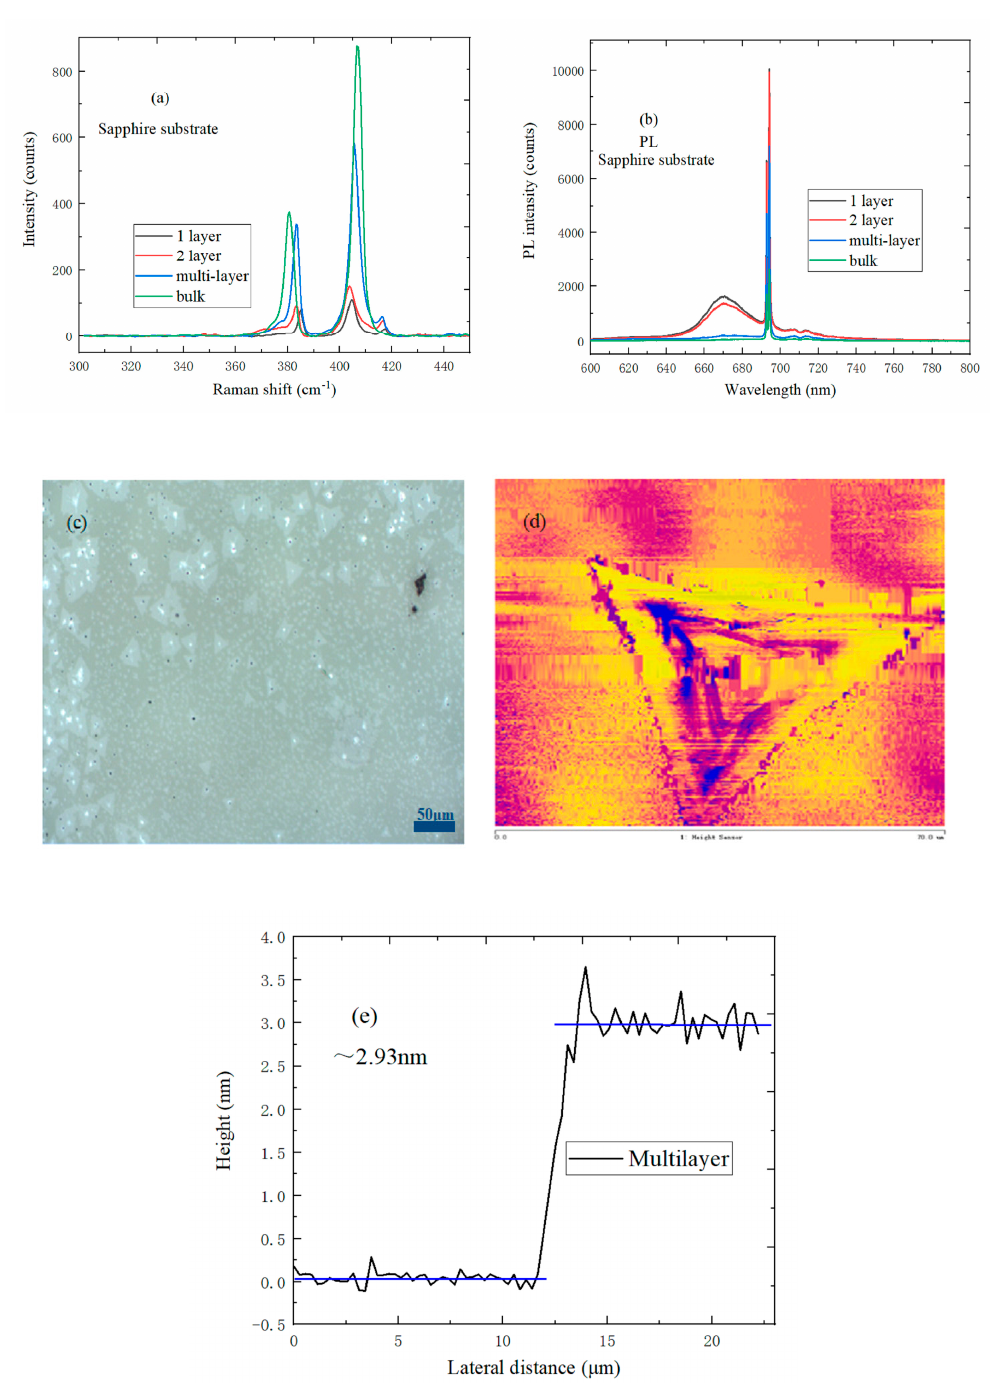
Figure 6. ( a ) Raman spectrum of MoS 2 with di ff erent layers on a sapphire substrate; ( b ) PL spectrum of MoS 2 with di ff erent layers on a sapphire substrate; ( c ) Optical micrograph of MoS 2 with di ff erent layers on a sapphire substrate; ( d ) AFM morphology of multilayer MoS 2 on a sapphire substrate; ( e ) Height profile of multilayer MoS 2 on a sapphire substrate.